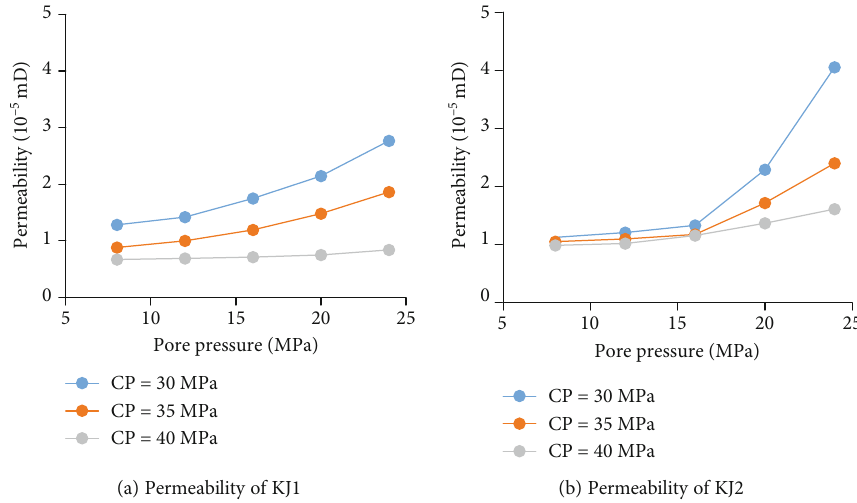
Figure 5: Matrix permeability at low pore pressure.